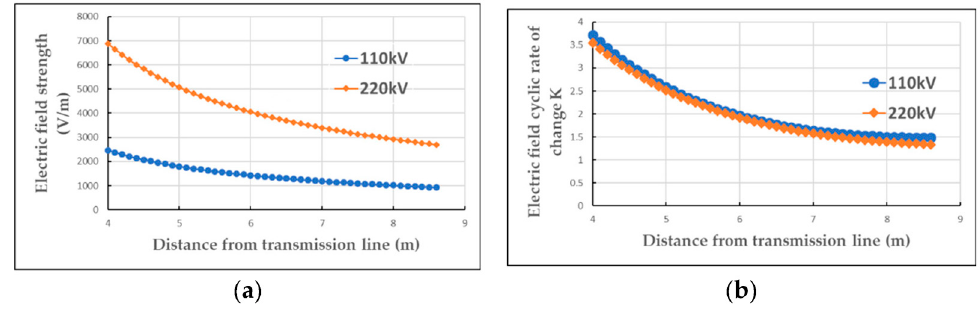
Figure 7. Electric field intensity and K value curve of 110 kV and 220 kV horizontal arrangement. ( a ) 110 kV and 220 kV electric field strength curve; ( b ) curve diagram of ring specific change rate of 110 kV and 220 kV electric fields.